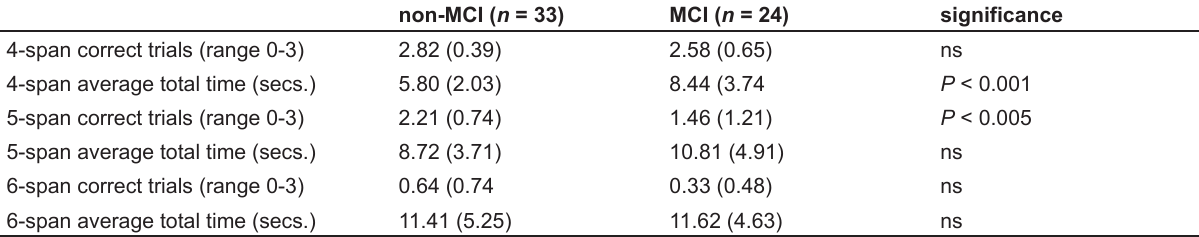
Table 3. Symbolic working memory—correct trials and average total time to completion